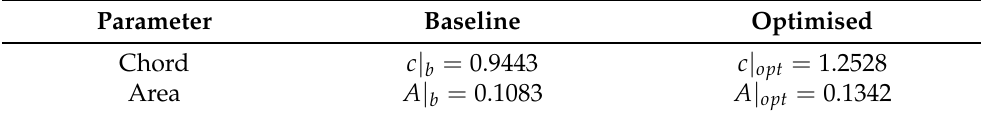
Table 5. Dimensionless chord and area from NLR7301 and definitive morphed